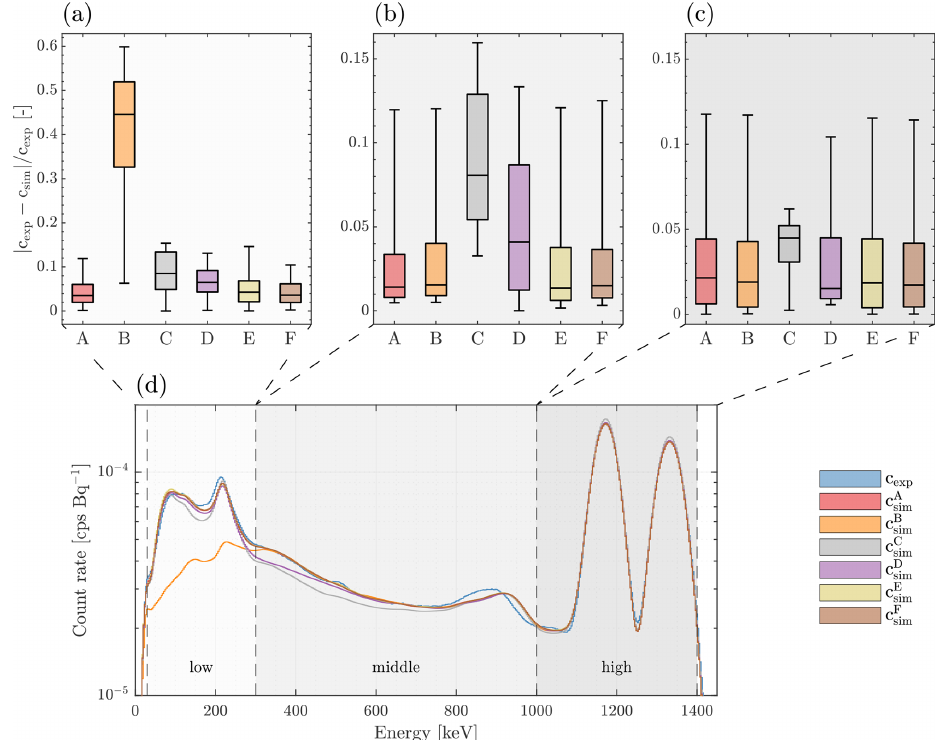
Figure 5. Monte Carlo model sensitivity analysis for the summed 60 Co scintillation spectra. (a) – (c) Adjusted box plots characterizing the statistical distribution of the relative spectral error between the experimental and simulated spectral detector response for different Monte Carlo models (A: reference; B: no laboratory elements; C: no detector box elements; D: no source elements; E: no additional laboratory equipment elements; F: MgO reflector) and three spectral windows: (a) low: µ LLD + 2 · σ LLD ≤ H k ≤ d 1 · 300keV, middle: (b) d 1 · 300keV ≤ H k ≤ d 1 · 1000keV and (c) high: d 1 · 1000keV ≤ H k ≤ d 1 · E FEP , max + 2 · σ res . The statistical analysis was performed using the Library for Robust Analysis (LIBRA) (Verboven and Hubert, 2005). (d) Mean count rate spectra for the 60 Co radiation measurement ( c exp ) and the different Monte Carlo models ( c A–F ) described above. The three spectral windows used to evaluate the box plots in Fig. 5a–b are highlighted. sim nificant effect of the scintillator non-proportionality on